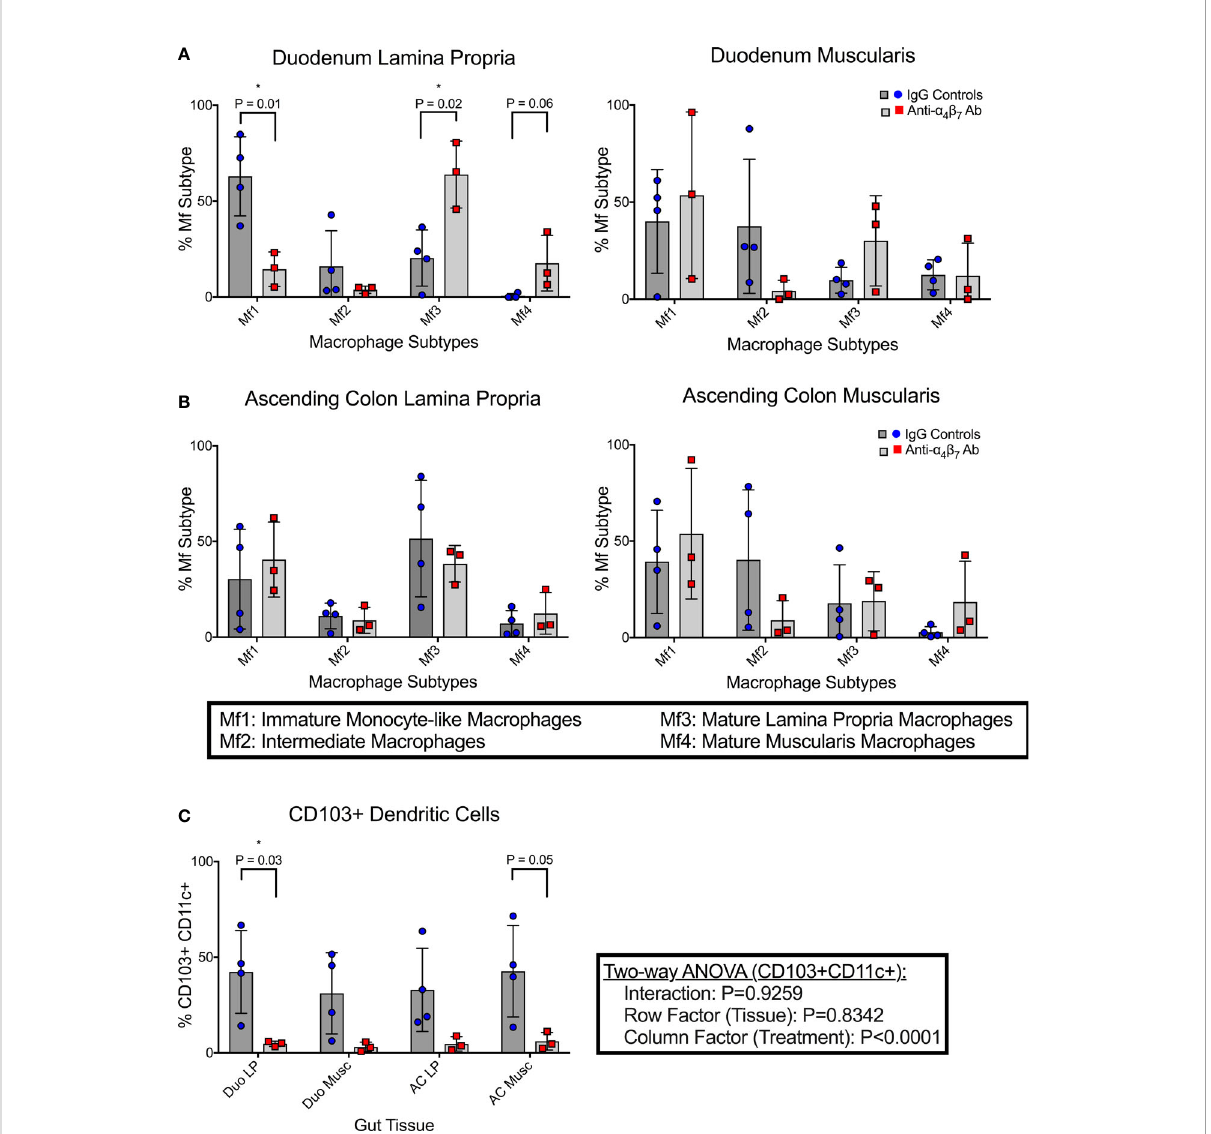
FIGURE 1 Anti- a 4 b 7 therapy is associated with reduced myeloid cell turnover in the small intestine. (A) Monocyte-like Mf1s were signi fi cantly lower in the duodenal lamina propria of anti- a 4 b 7 -treated macaques compared with controls, while mature Mf3 were substantially higher. Similar